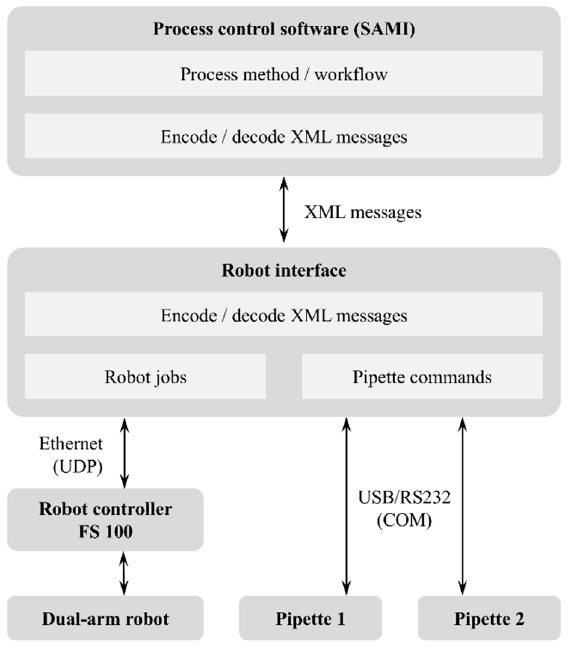
Figure 3. Software design for robot and pipette control [14].